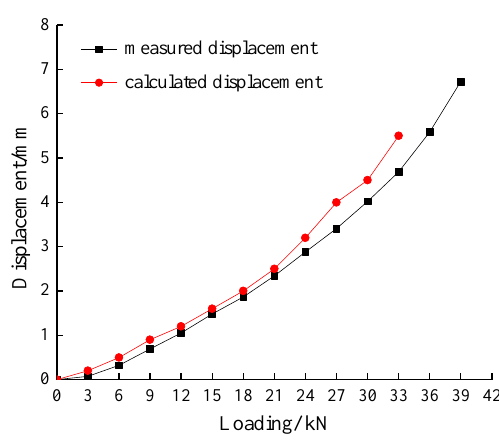
Figure 7. The load–displacement curves for the test and numerical simulation.